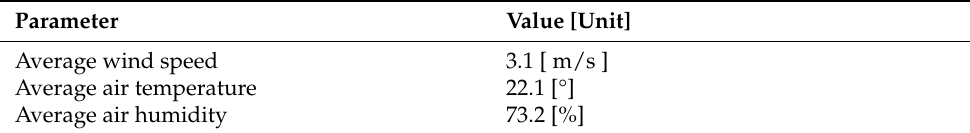
Figure 14. VTOL linear speeds during the in-flight test. Table 3. Weather conditions during the tests.